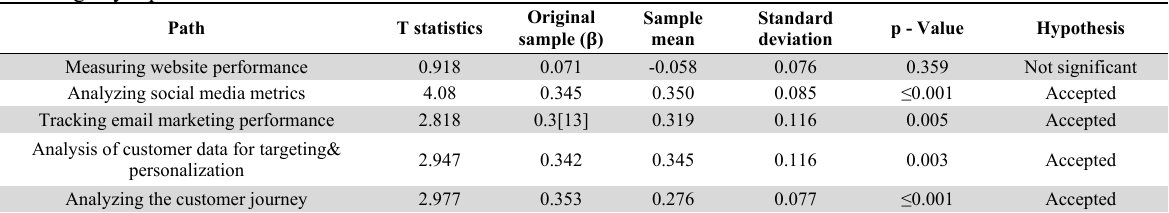
Findings Synopsis Path T